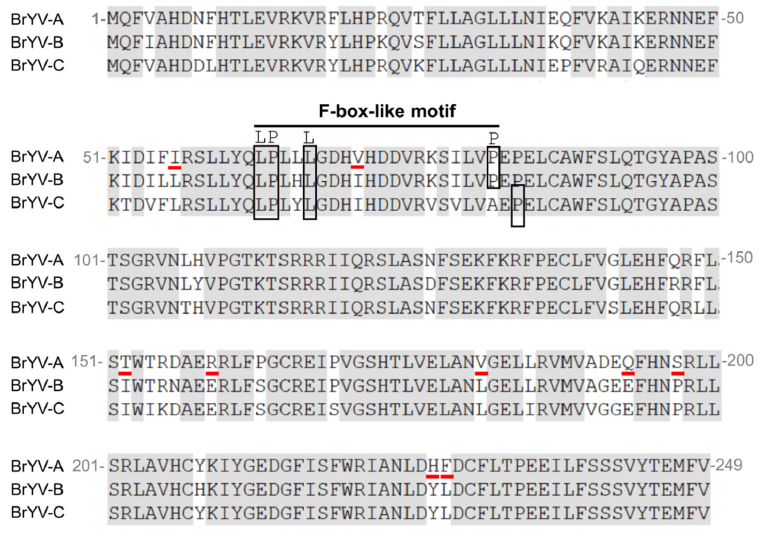
Figure 3. Multiple alignments of amino acid sequences from P0 BrA , P0 BrB , and P0 BrC . All the conserved residues are indicated in gray background. The mutated amino acids of the nine mutants are presented by red underlines. Landmark residues of the F-box-like motif are highlight in the boxes. The P0 sequences used are as follows: BrYV-A (Accession No. HQ388348), BrYV-B (Accession No. HQ388351), and BrYV-C (Accession No. KF015269). The numbers correspond to the positions of amino acids within the P0 Br